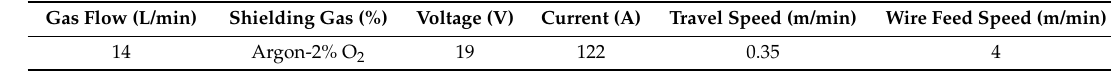
Table 2. Welding conditions used in this study.